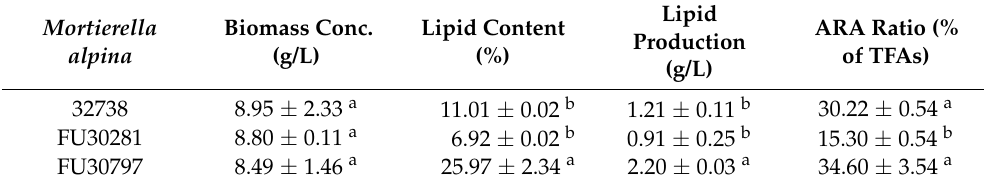
Table 1. Biomass concentration, lipid content, lipid production and ARA ratio of different Mortierella alpina strains. Mortierella